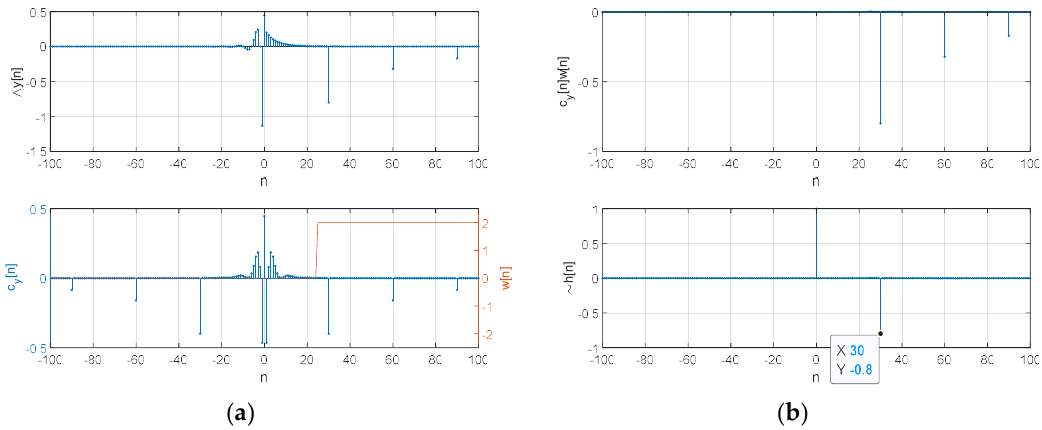
Figure A1. HD computational procedures for numerical example: ( a ) Complex cepstrum (above) and real cepstrum (below); ( b ) FILF output (above) and estimated propagation function (below).